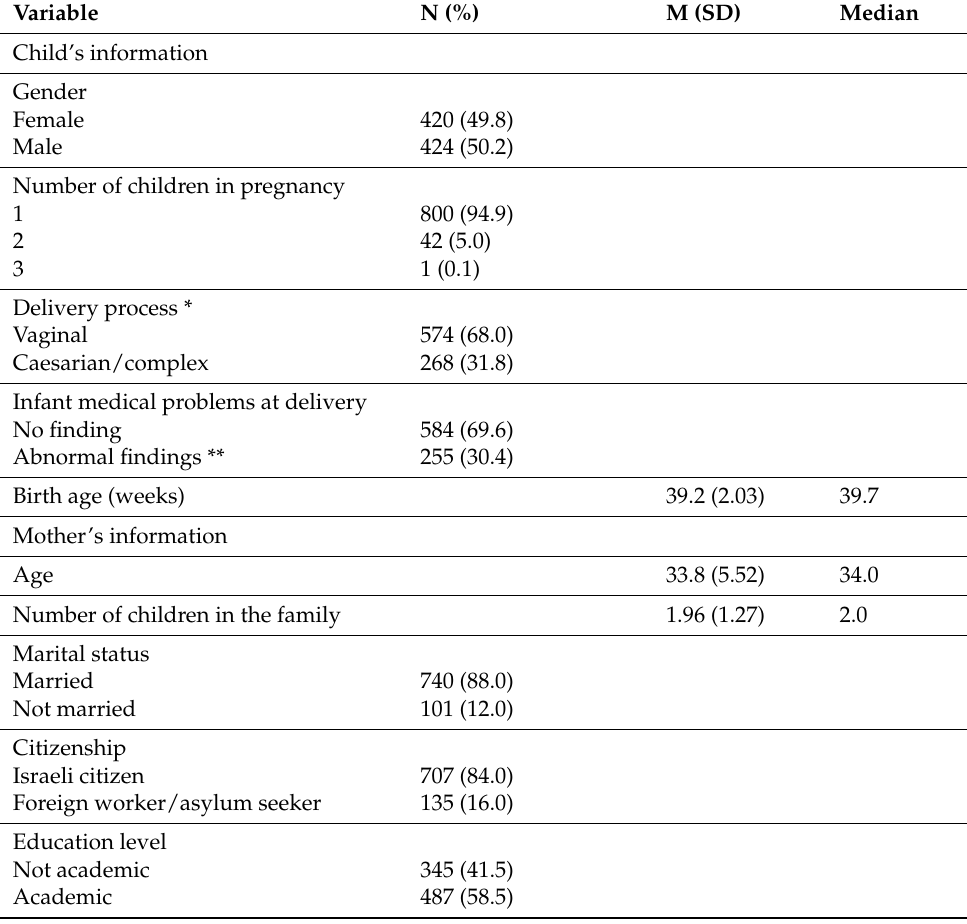
Table A1. Sample characteristics (n =